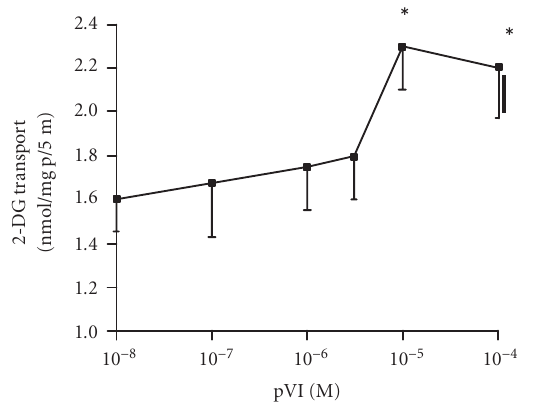
(b) E ff ect of pVI on 2-DG transport in 3T3 adipocytes. Figure 3. E ff ect of di ff erent vanadate compounds at several concentrations onbasalandinsulin-stimulated2-DGtransportin3T3-L1adipocytes.Panel (a) pVA; ∗ P < . 05, 1-way ANOVA, F = 23 . 3, n = 3 (triplicate plates in all experiments). Panel (b) pVI; ∗ P < . 05, 1-way ANOVA, F = 7 . 7, n = 3 (tripli- cate plates in all experiments). All data ± SE. pVA or pVI exposure time was 60minutes. See Materials and Methods for additional experimental